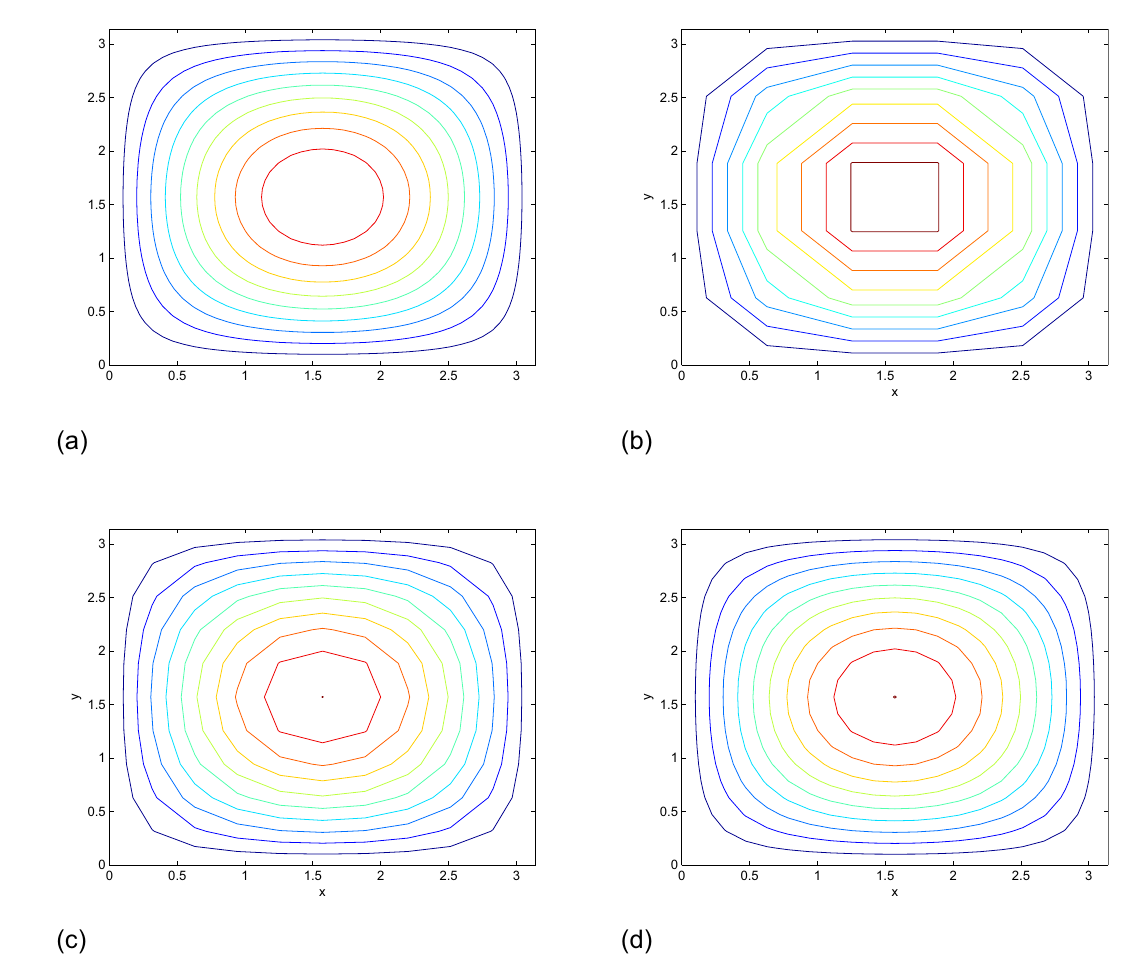
Figure 3: The contour plot of the exact solution and the numerical solutions using the compact ADI scheme for di ff erent M at = T 1 with = α 1.5 , = N 100 for Example 1. ( a ) Exact solution, ( b )